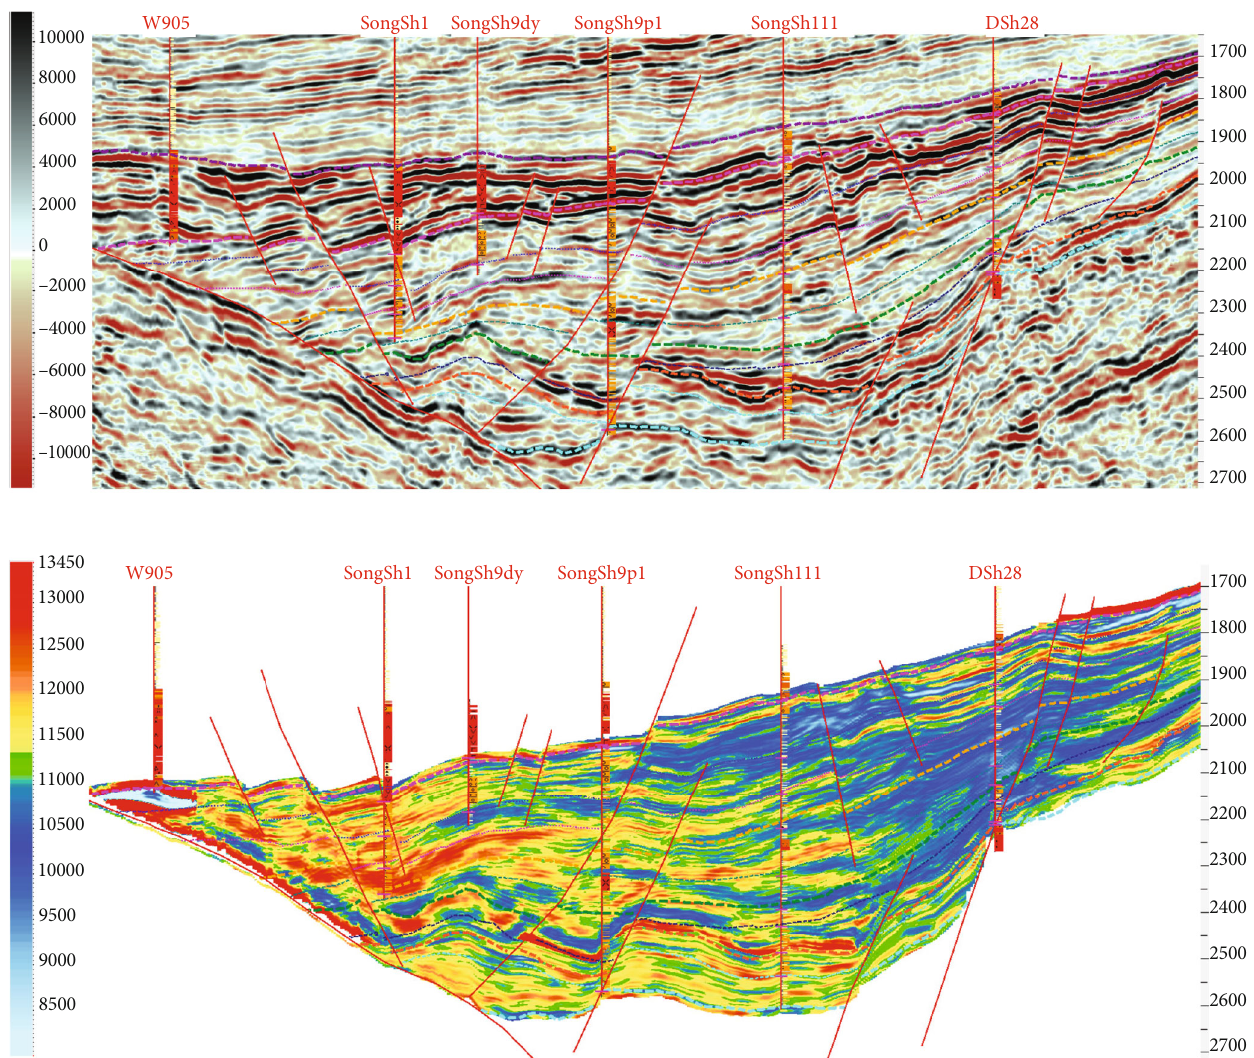
Figure 9: Facies controlled inversion of P-impedance pro fi le and seismic pro fi